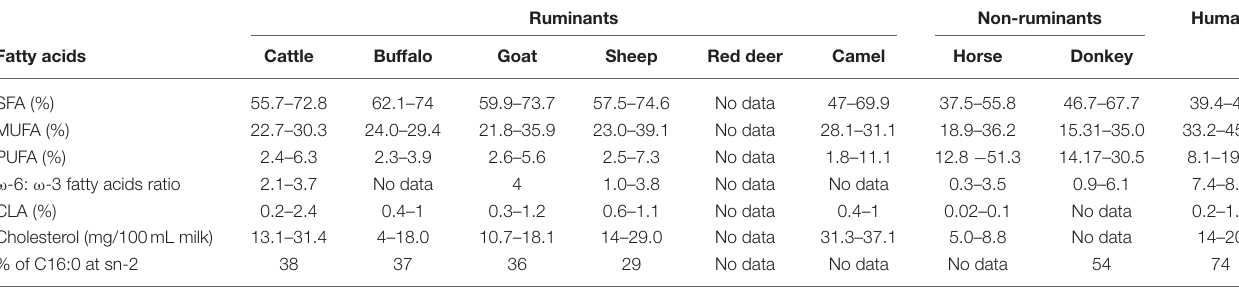
TABLE 4 | Fatty acid profile (% of total fatty acids) and cholesterol content of milk from different mammalian species # .